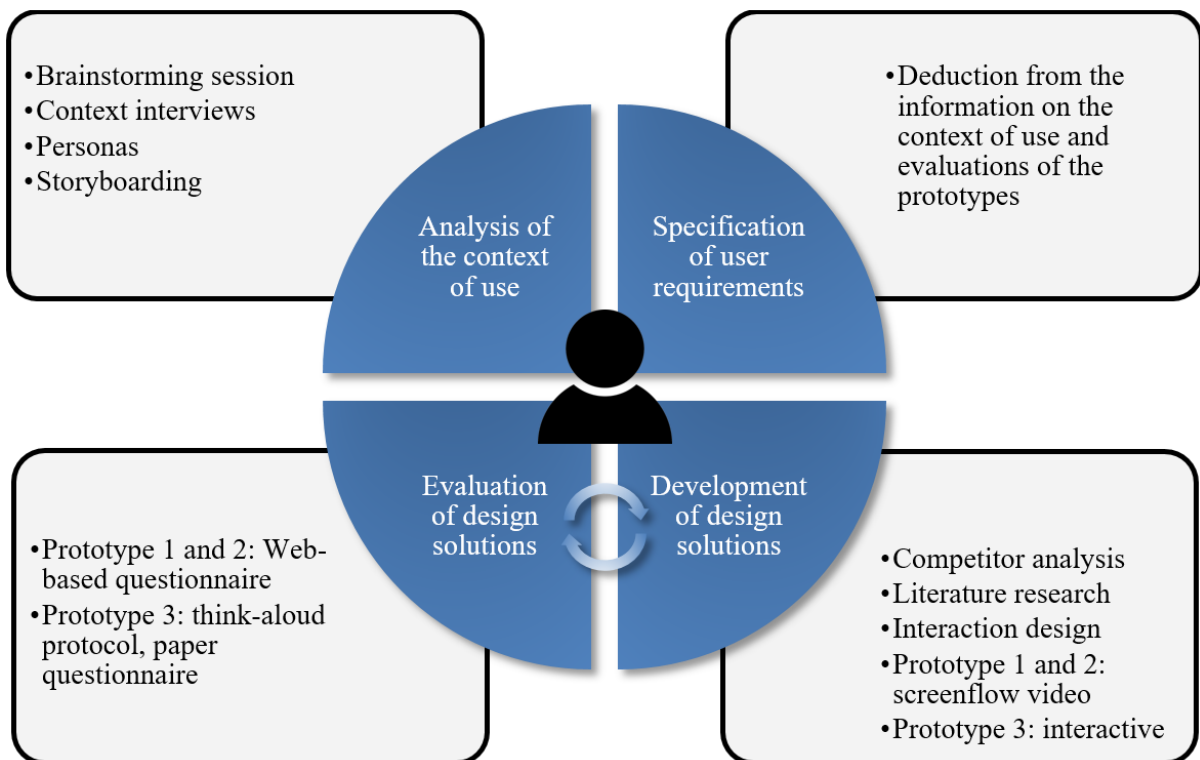
Figure 1. Study process